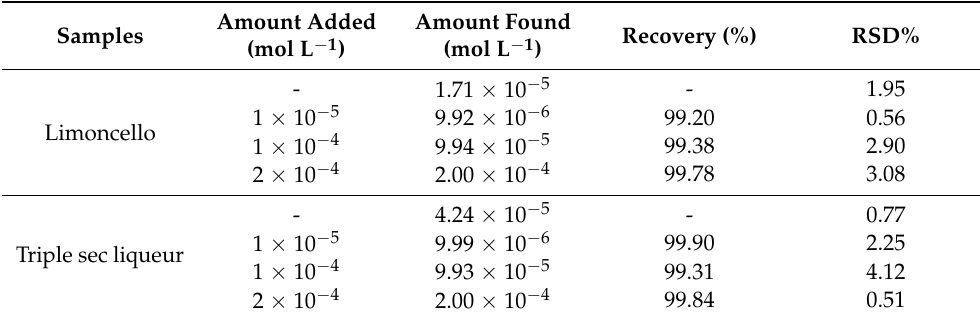
Table 6. Detection of R-Limonene in limoncello and liqueur triple sec samples using the Fe(TPFPP)Cl/AuNPs-S-Gr sensor. Samples